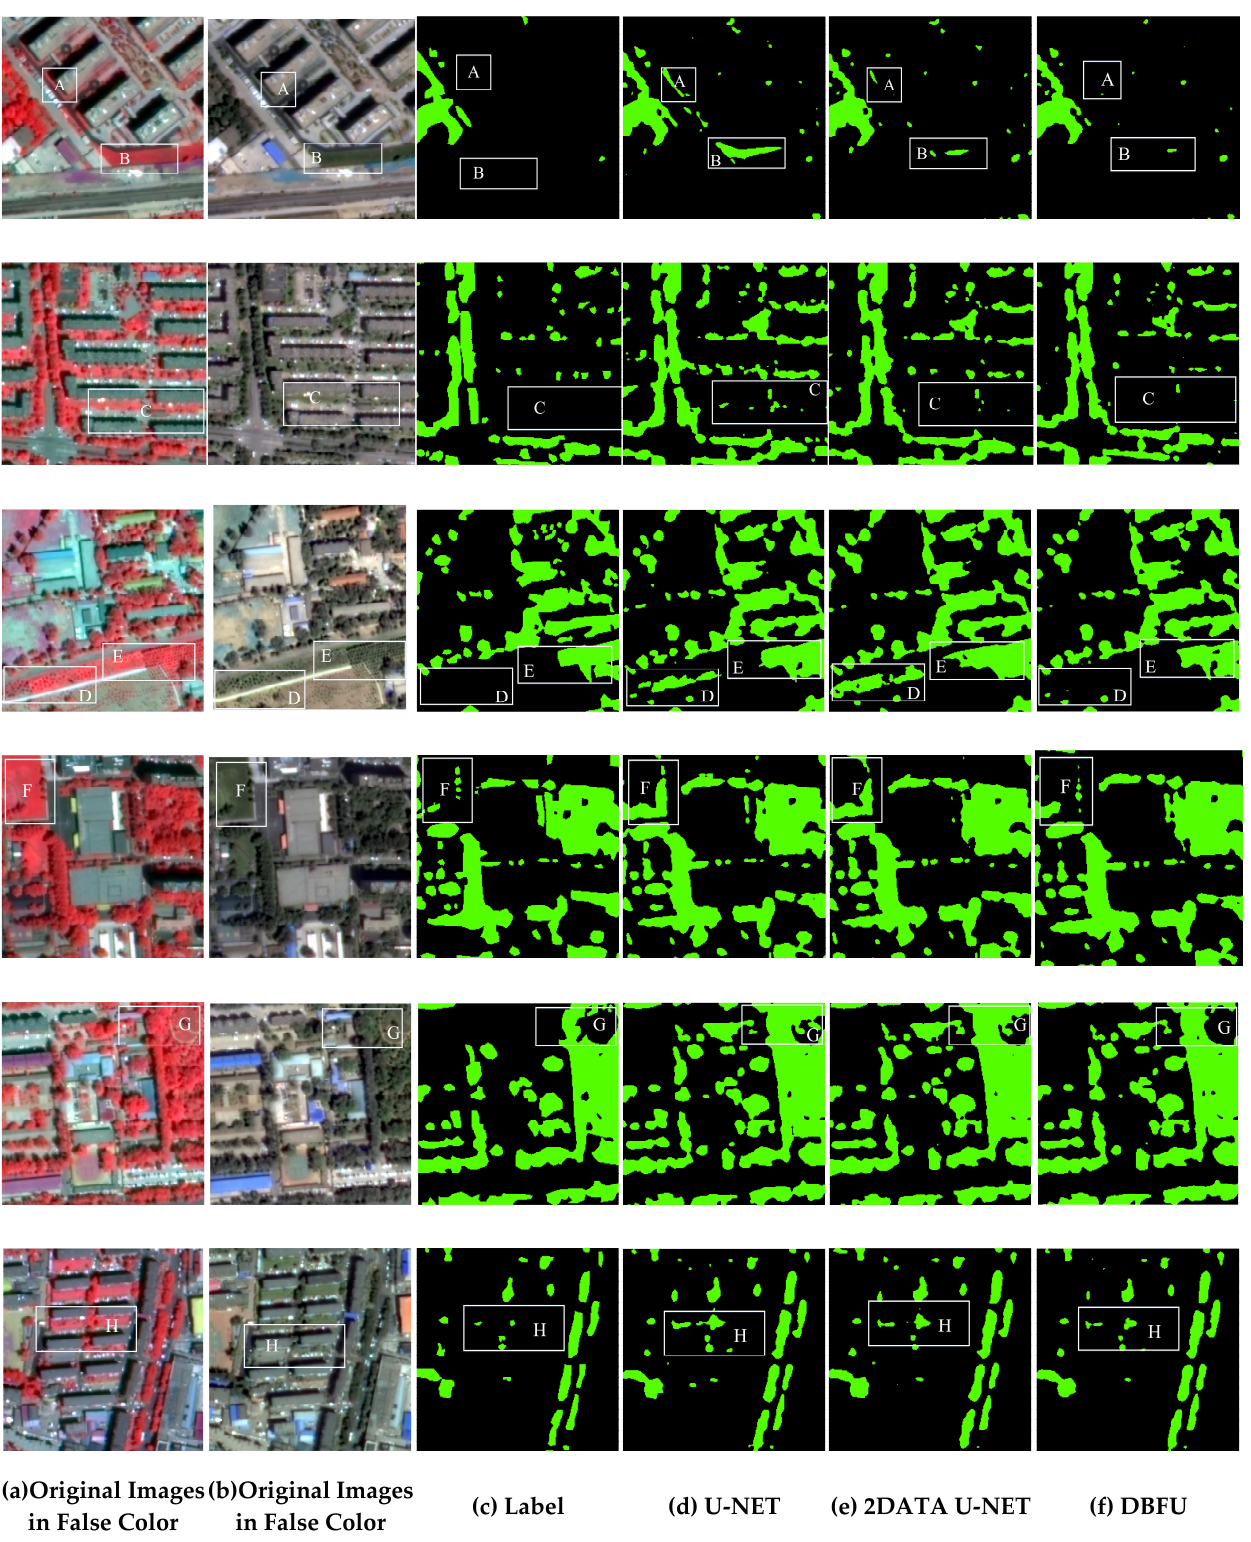
Figure 12. Comparison of classification results of DBFU, U-NET and 2DATA U-NET: ( a ) original images in false color, ( b ) original images in real color, ( c ) ground truth, ( d ) classification results of U-NET, ( e ) classification results of 2DATA U-NET. ( f ) classification results of